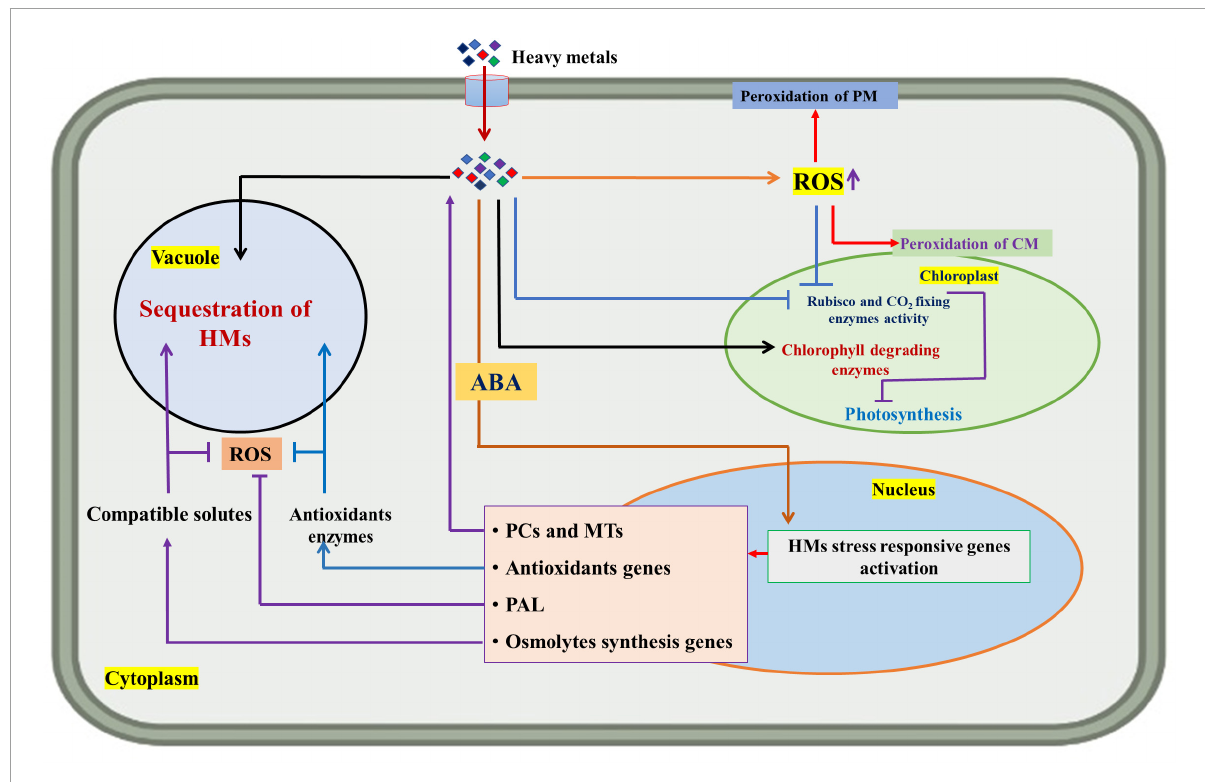
FIGURE4 Diagram showing the sequestration mechanism of heavy metals (HMs) in plant cells and the role of abscisic acid (ABA) in mitigating HM stress. ROS (reactive oxygen species), PM (plasma membrane), CM (chloroplast membrane), PCs (phytochelatins), MTs (metallothioneins), and PAL (phenylalanine